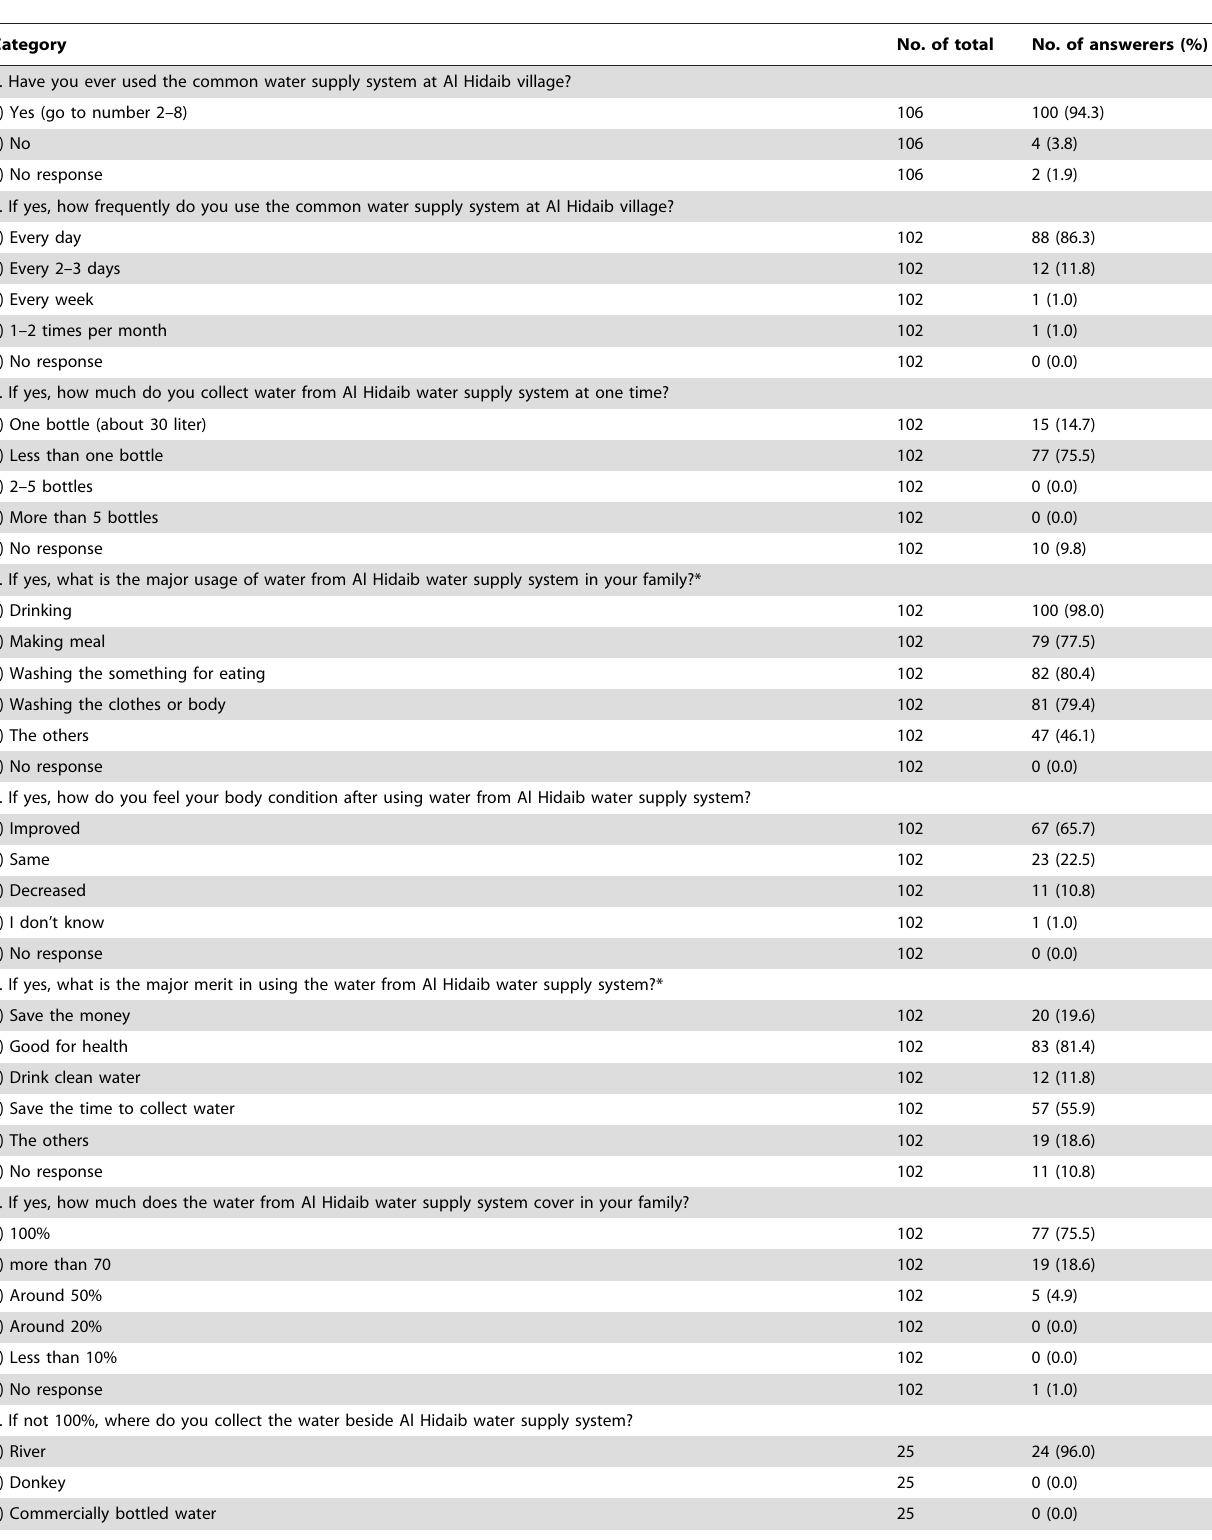
Table 10. The results of questionnaires for evaluation of common water supply facility at Al Hidaib villages of Al Jabalin unit, White Nile State,